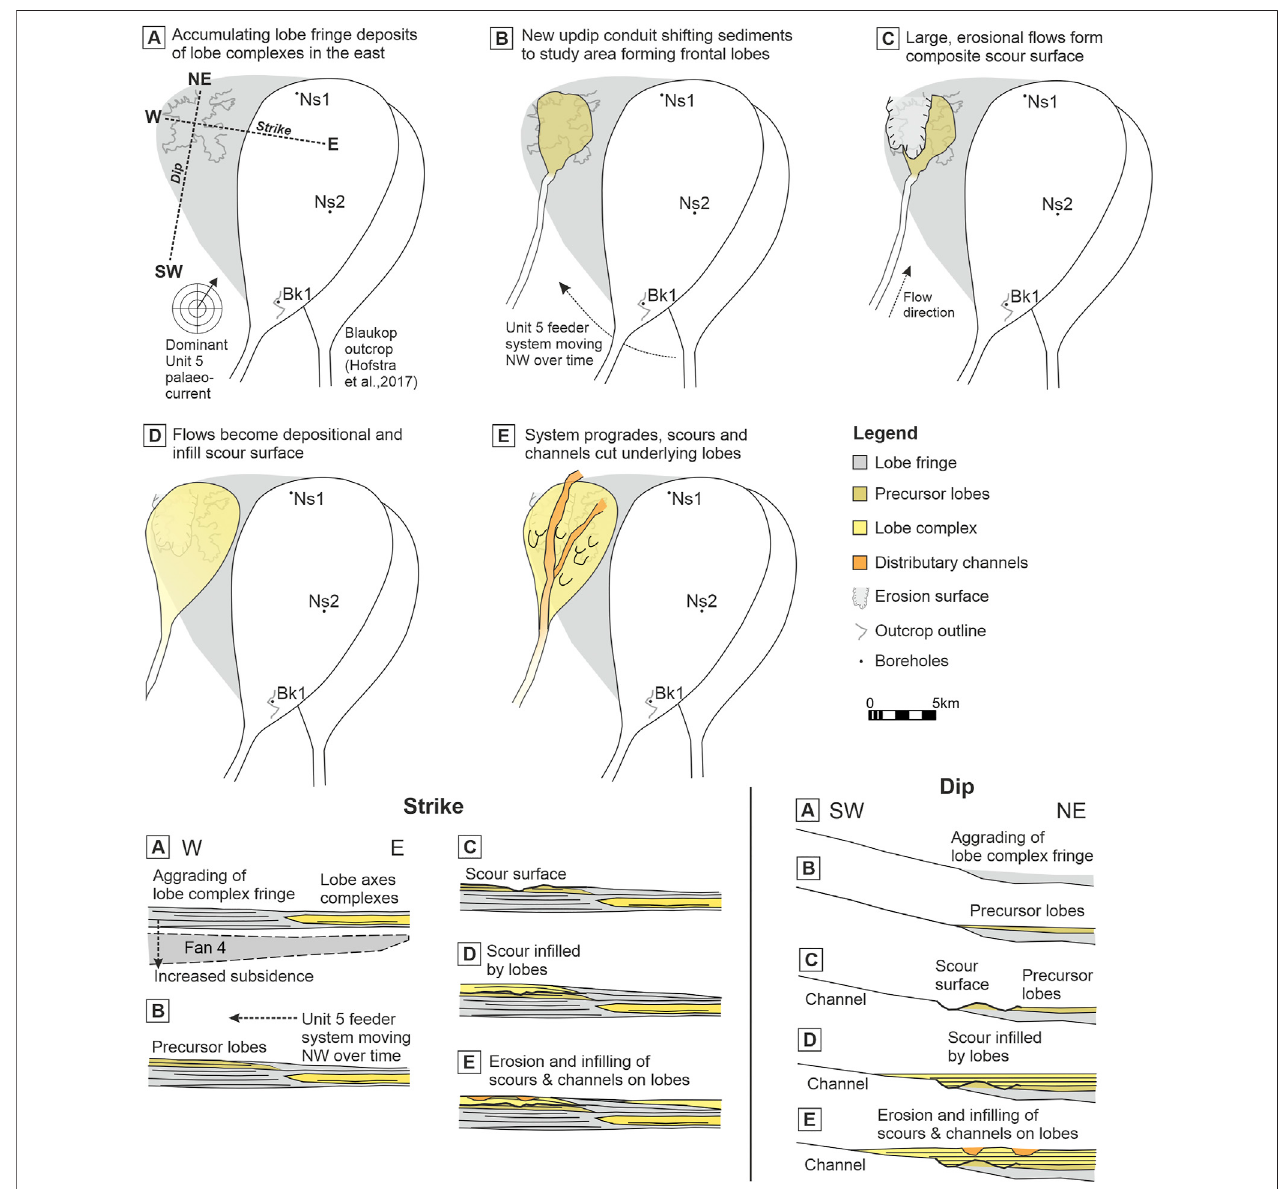
FIGURE 11 | Stratigraphic evolution of Unit 5 at Skoorsteenberg shown from (A) to (E) . Stacking patterns of deposits related to (A) to (E) in both strike and dip sections are also shown.